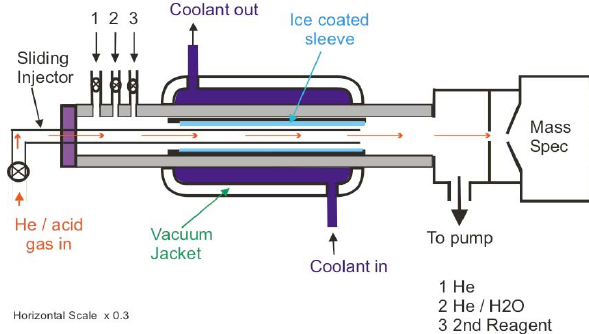
Fig. 4. Schematic of flow tube used for measurements of uptake of trace gases on ice (Symington, 2009). A smooth ice film is produced by freezing pure water on the inside of a liner inserted into the flow tube held at 258 K. The trace gas diluted in He is introduced via a sliding injector. Reactant gas is added through a sliding injector. By varying the distance between694 the sliding injector and the detector, the time of exposure of the reactant gas to the695 condensed phase can be varied, allowing a pseudo-first order rate constant for removal of696 , to be measured, provided there is not significant surface saturation.697 the gas, k s Alternately the total amount of trace gas adsorbed on a prescribed surface area can be698 measured over a period of time at a fixed distance, providing information on surface699 coverage at saturation. This can be used to investigate adsorption characteristics and700 determine partitioning coefficients, e.g. to ice surfaces.701 A variety of on-line sensitive detection schemes have been used, generally either702 spectroscopic or mass spectrometry with differential pumping (MS). Electron impact MS703 has been widely used. Additional sensitivity and selectivity has resulted from recent704 developments in chemical ionization mass spectrometry (CIMS). Optical detection705 techniques have included laser-induced fluorescence, UV and IR absorption and chemi-706 luminescence.707 The net uptake probability from coated wall flow tube experiments can be708 evaluated from:709 710 2 rk s 711 (cid:1) = c 712 where r is the radius of the tube and c is the mean molecular speed. Correction of713